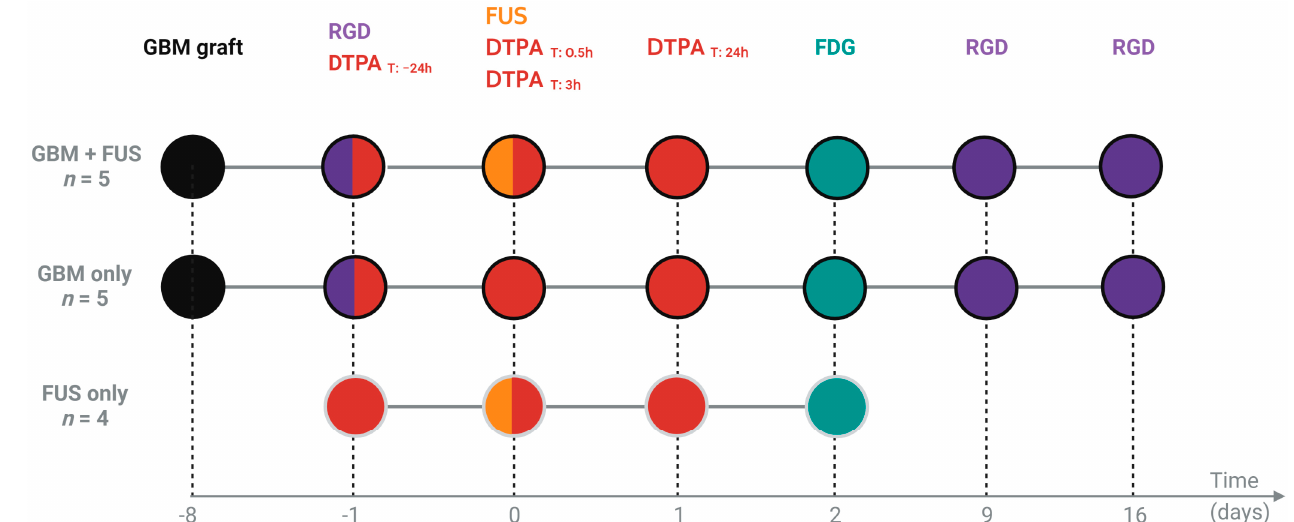
Figure 1. Schematic representation of the experimental plan used for the FUS ‐ induced hemispheric BBB permeabilization and imaging study on healthy and tumor ‐ bearing animals. Group “GBM+FUS“: tumor ‐ bearing animals undergoing FUS ‐ mediated BBB permeabilization; Group “GBM only”: tumor ‐ bearing animals without BBB permeabilization (tumor growth control); Group “FUS only”: healthy animals undergoing FUS ‐ mediated BBB permeabilization (BBB opening control).